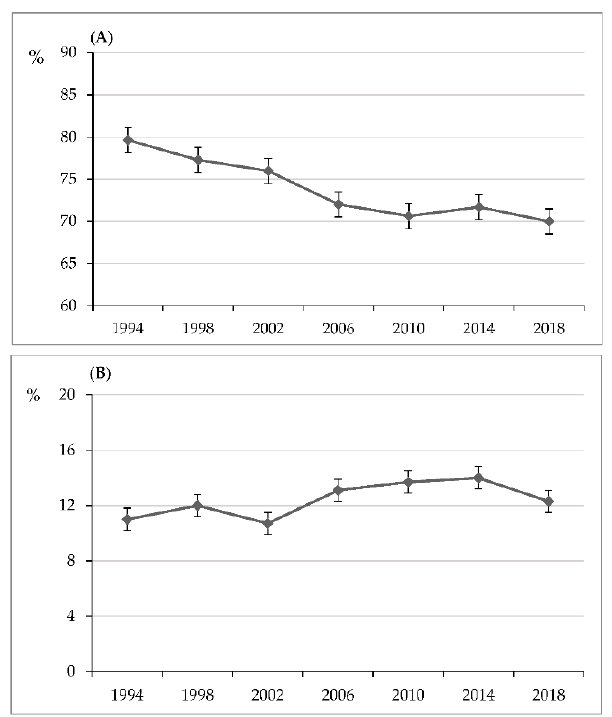
Figure 5. Time trend of the proportion of families where the adolescent lived with both parents ( A ) and with a single mother ( B ) over 1994–2018 in 28 HBSC countries (see Table 2), except England, Germany, Greece, Ireland, Portugal, and Wales in 1994; Belgium (French) and Spain in 1998; Slovakia in 2002; Israel and Russia in 2010; and Israel in 2018. Vertical bars indicate a standard error.